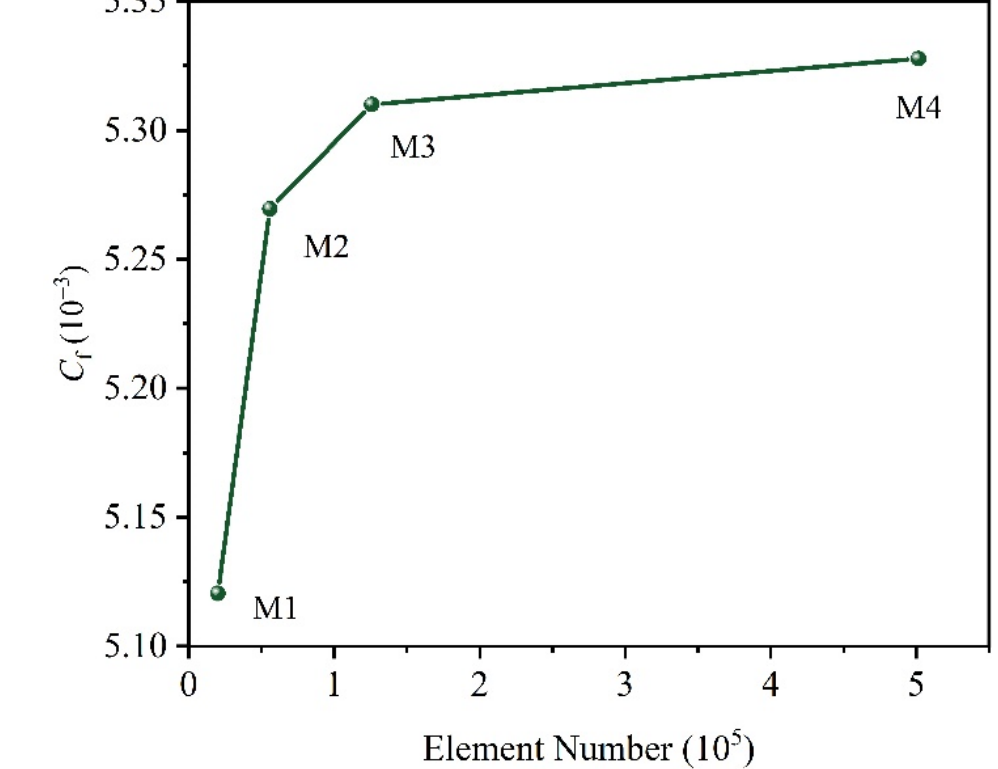
Figure 3. The structured mesh used in the numerical simulations for three types of grooves.